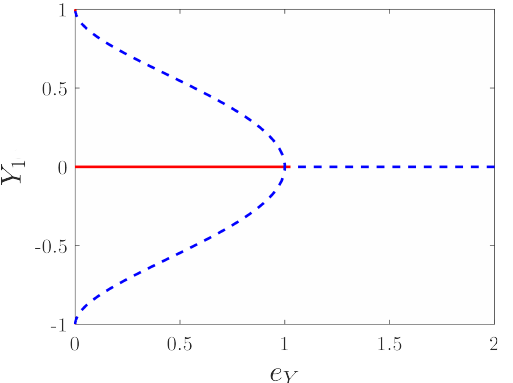
Figure 2. Bifurcation diagram of the equilibrium point with variation of e Y , β Y = 0.05.